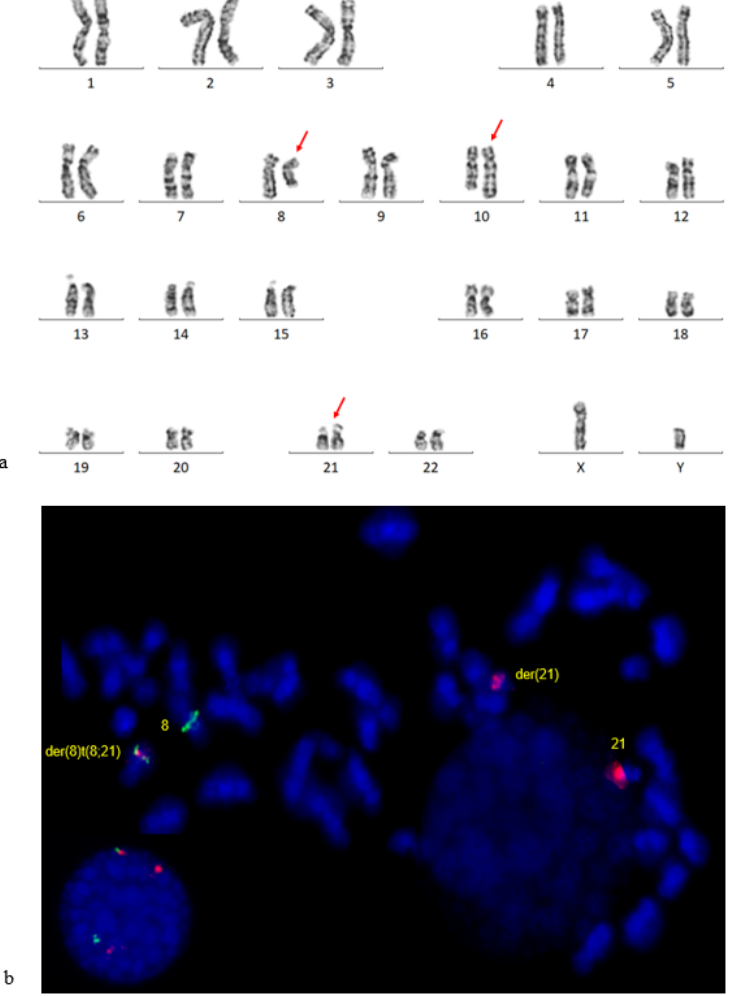
Figure 2. Cytogenetic findings of Patient 2. ( a ) A representative karyogram: 45,XY,t(8;10;21)(q22;q25;q22). The derivative 21q was cryptic. ( b ) FISH using a dual-fusion probe RUNX1 (red)/ RUNX1T1 (green) revealed RUNX1::RUNX1T1 fusion on the derivative